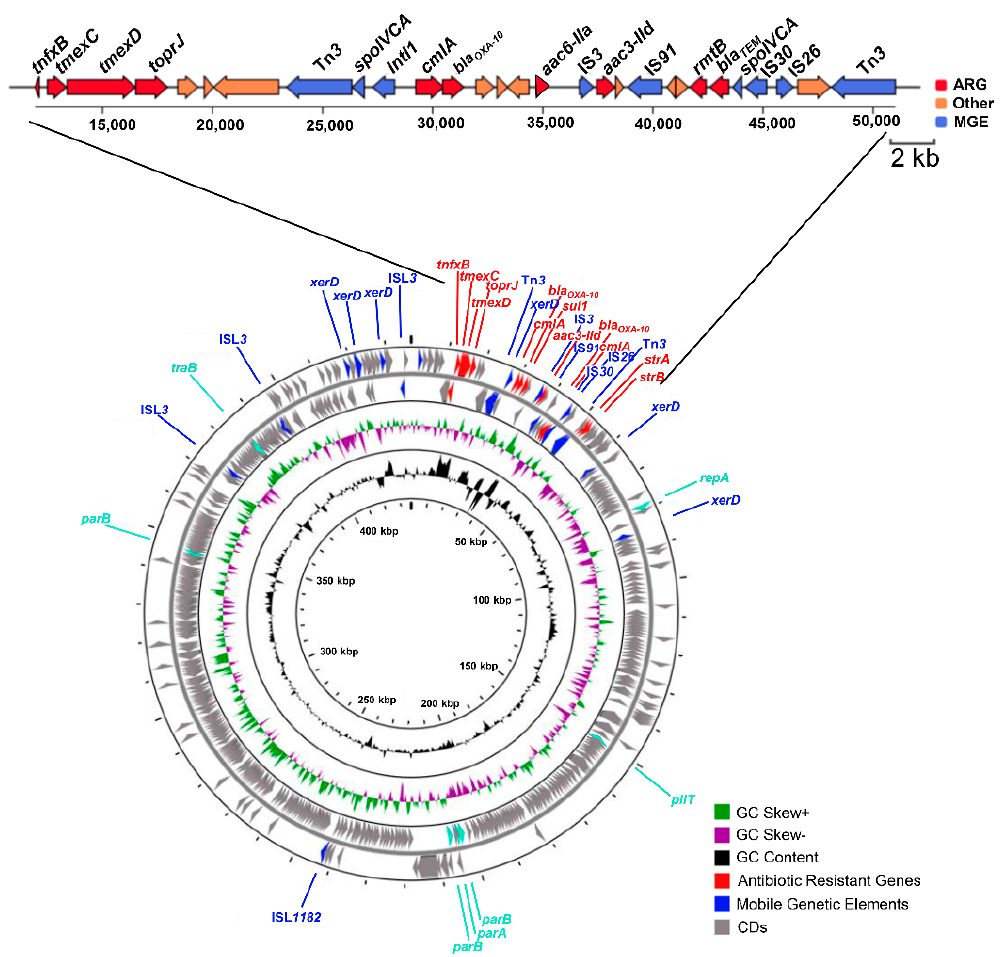
Figure 2. Schematic map of the pTJPa150 plasmid. The innermost circle is the scale. The GC content is illustrated in the second circle. The third circle shows GC skew (+: green, − : purple). The outermost circle indicates the CDs, in which antibiotic resistance genes are highlighted in red and mobile genetic elements in blue.